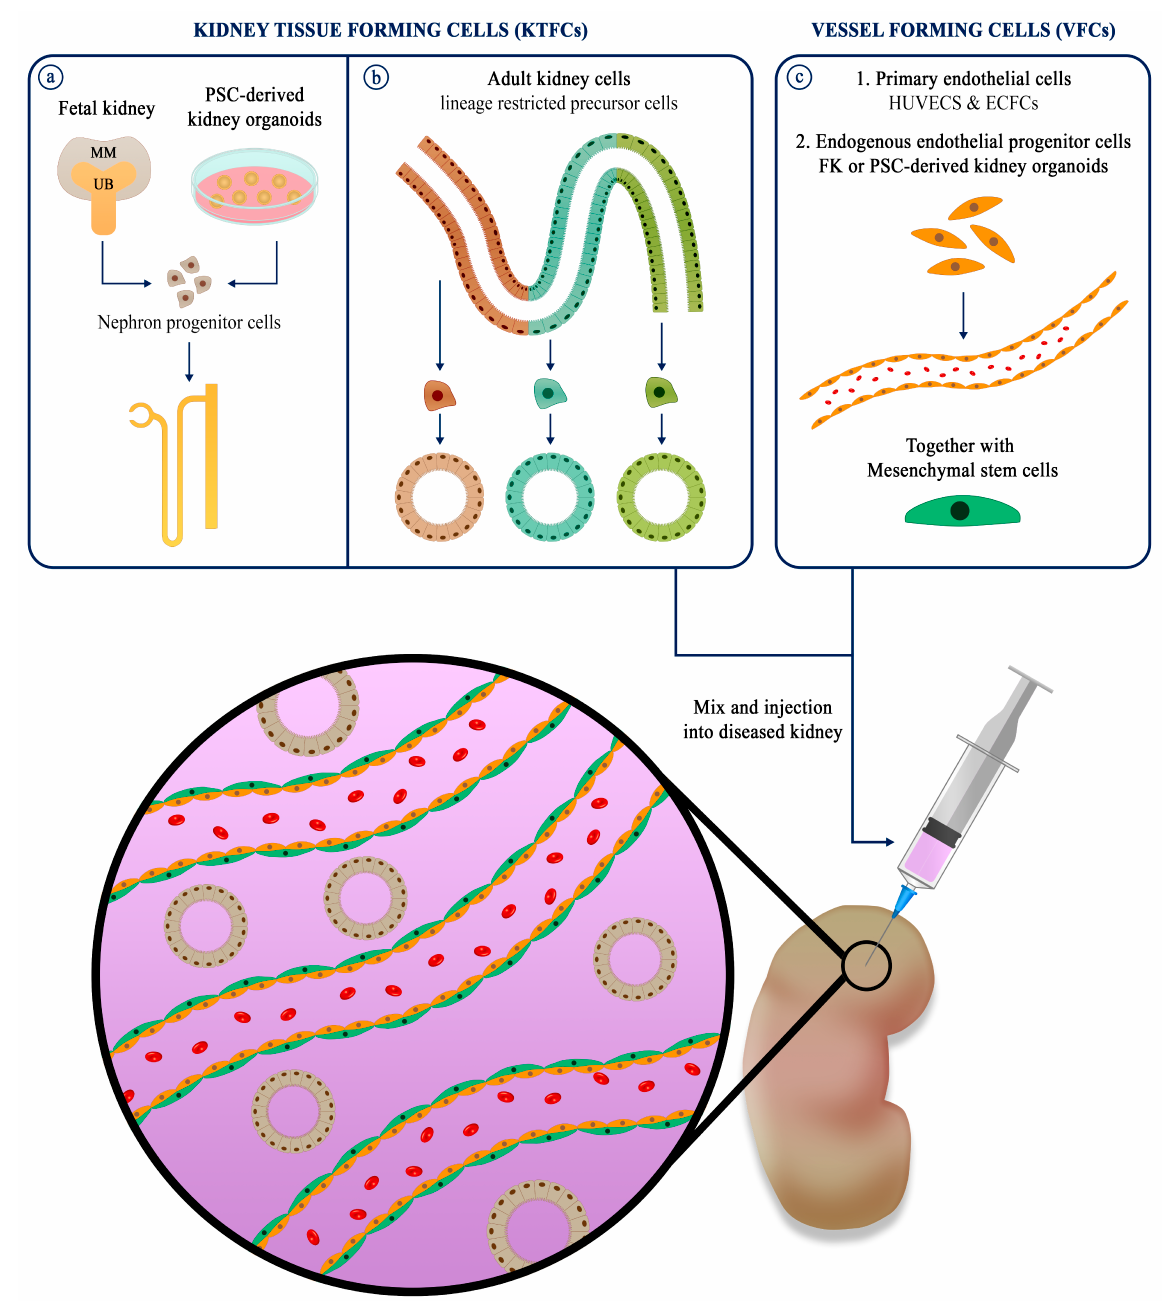
Figure 1. Overview of engraftment strategy for vascularized kidney regenerative medicine. ( a ) KTFCs from fetal kidney or PSC-derived kidney organoids have the capacity to differentiate into nephrons with glomerulus, proximal tubule, loop of Henle and distal tubule. ( b ) KTFCs from adult kidney derived from biopsies of urine samples are lineage restricted precursor cells, able to generate segment specific tubules. ( c ) VFCs such as endothelial cells and peritubular support cells (pericytes and mesenchymal stem cells) are added to the cell mix to support blood vessel formation. Adapted from reference